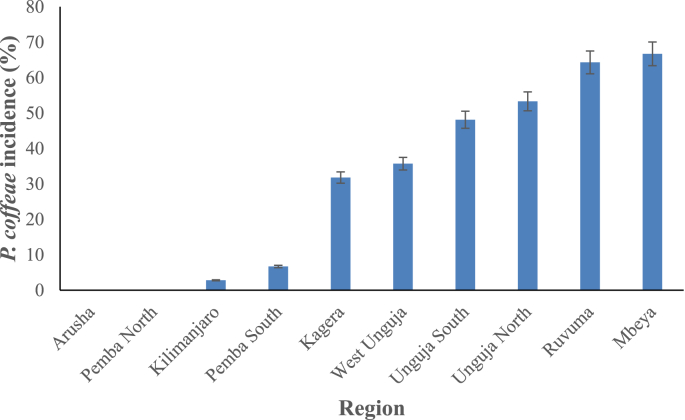
Percentage incidence of Pratylenchus coffeae from all banana root samples collected from 10 regions of Tanzania. The error bars represent a 5% error.